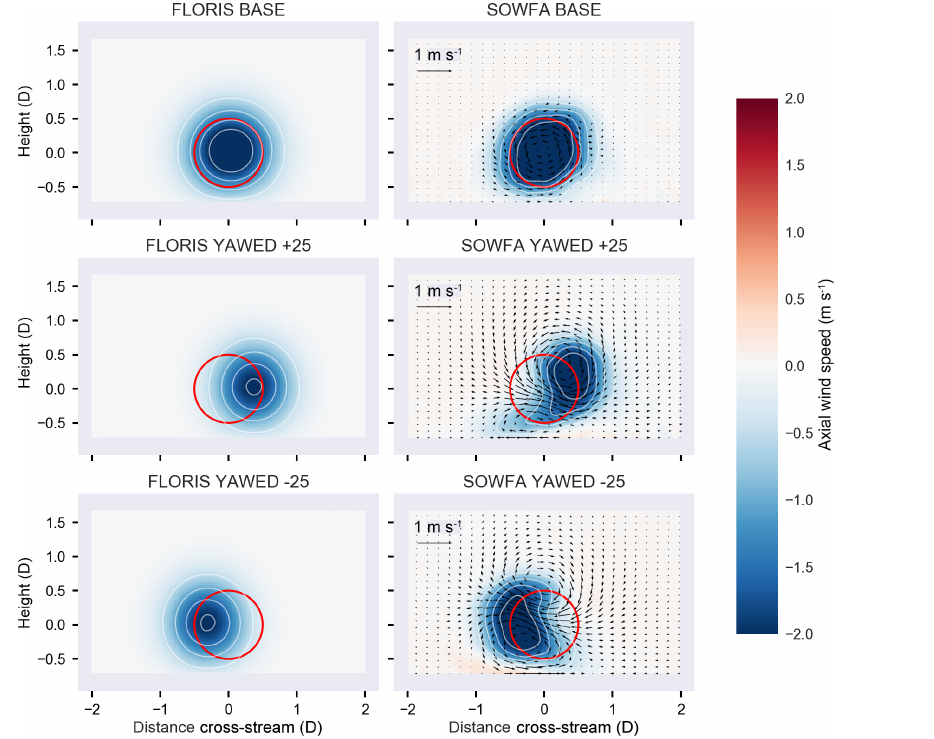
Figure 3. Cut-through of SOWFA flow (viewed from upstream), minus the background flow, at a distance of 7 diameters behind the turbine for baseline and yawed 25 and − 25 ◦ . Deficit in axial flow is shown in blue, saturating at a deficit of 2ms − 1 to broadly show the wake area. For the SOWFA cases, the in-plane flow is visualized by arrows whose relative size indicates the strength of the flow. Red circles indicate a rotor located directly downstream of the